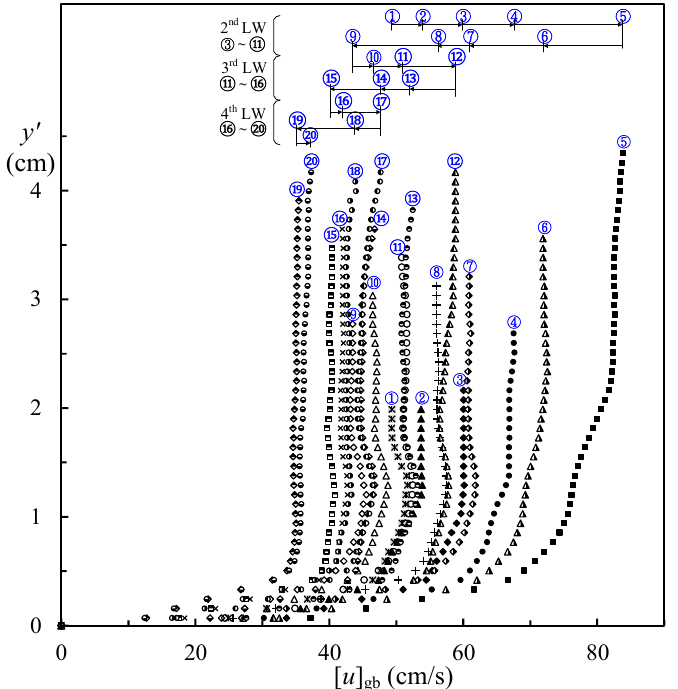
Figure 8. Temporal variation of horizontal velocity profile of generated bore with 2nd, 3rd, and 4th leading waves obtained at SMS for 2.008 s ≤ t ≤ 3.462 s during run-up motion. Corresponding times labeled from circled 1 to 20 are listed in sub-table of Figure 7b.